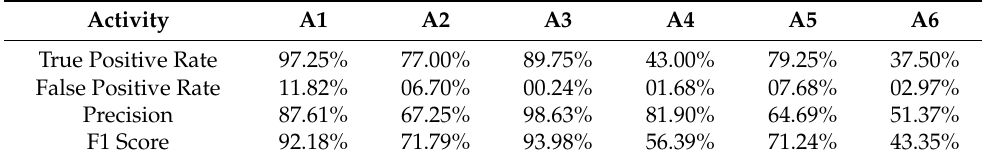
Table 13. The results of our proposed approach obtained for the fourth evaluation scenario.